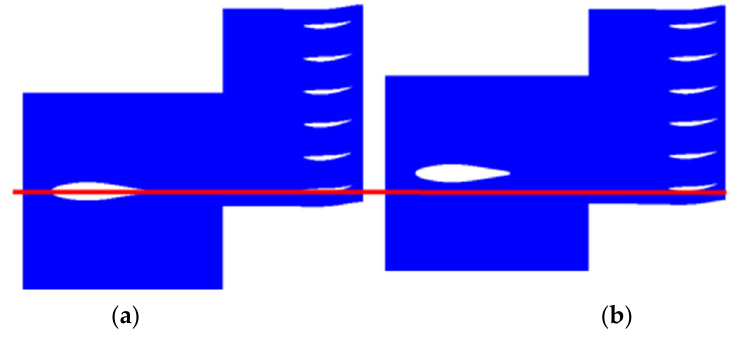
Figure 2. Circumferential relative positions of struts and IGVs. ( a ) C# ( b ) M#.